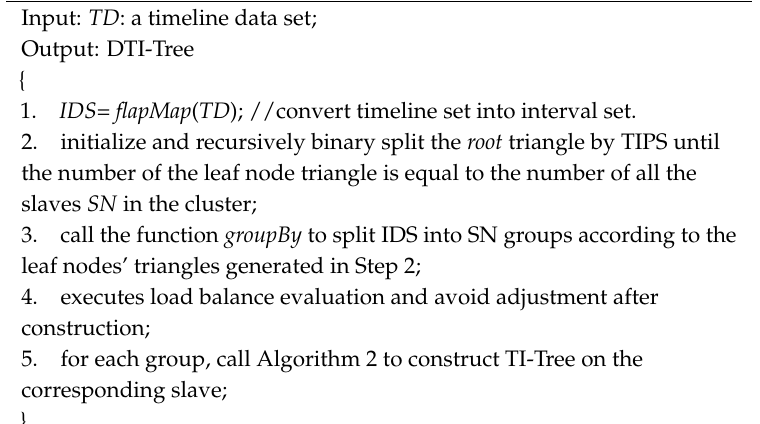
Algorithm 3: DTI-Tree construction shown in Figure 10